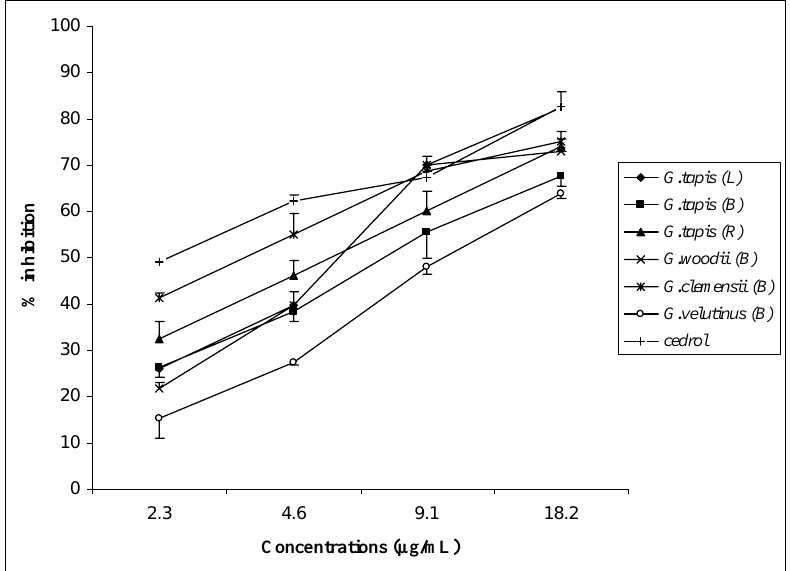
Figure 2. Inhibitory effect of the leaf (L), bark (B) and root (R) oils of Goniothalamus tapis , bark oils of G. woodii , G. clemensii and G. velutinus and cedrol on PAF receptor binding to rabbit platelets. Each point represents the mean of three experiments, each in triplicate. Standard deviation of the mean are indicated as vertical